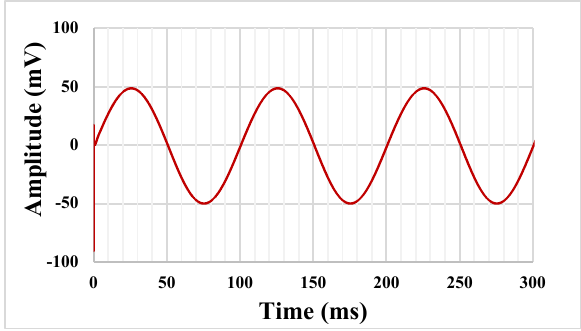
Figure 11. The histogram of the −3 dB cut-off frequency ( a ) and low frequency gain ( b ) of the LPF with 200 MC runs.